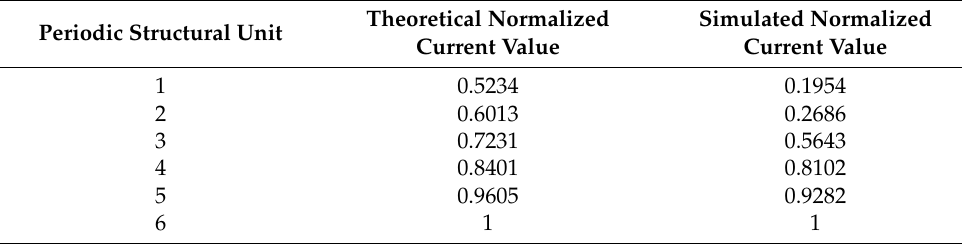
Table 2. Theoretical normalized current values calculated by Taylor weighting and simulated nor- malized current values for 11 periodic structural units.